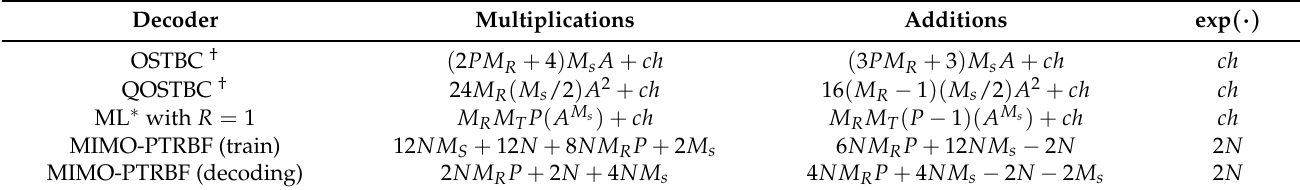
Table 2. Computational